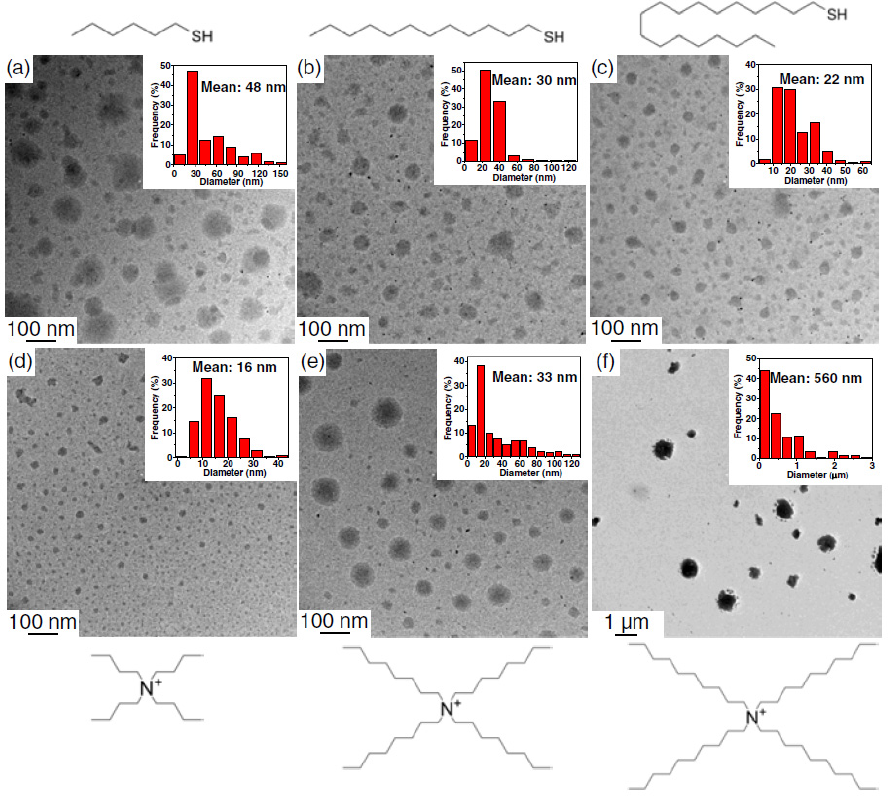
Figure 10. TEM images of LiBH 4 nanoparticles prepared with ( a – c ) tiol-based surfactants; ( d – f ) ammonium-based surfac- Figure tants with different chain lengths. Reprinted with permission from [161]. Copyright (2019), John Wiley and Sons.